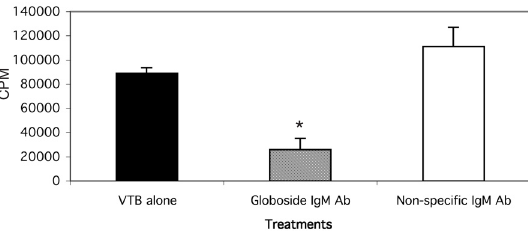
Figure 5 Effect of globoside antibody pretreatment on VTB binding of I 125 -labeled B19 VP2 empty capsid. Equal numbers (2.5 6 10 5 ) of VTB were either untreated (black bar), or pretreated with 10 m g globoside IgM Mab (hatched bar), or with 10 m g non-specific IgM Mab (white bar) before incubation with 1.5 m g I 125 -labeled B19 VP2 empty capsid. Error bars represent standard deviation of the